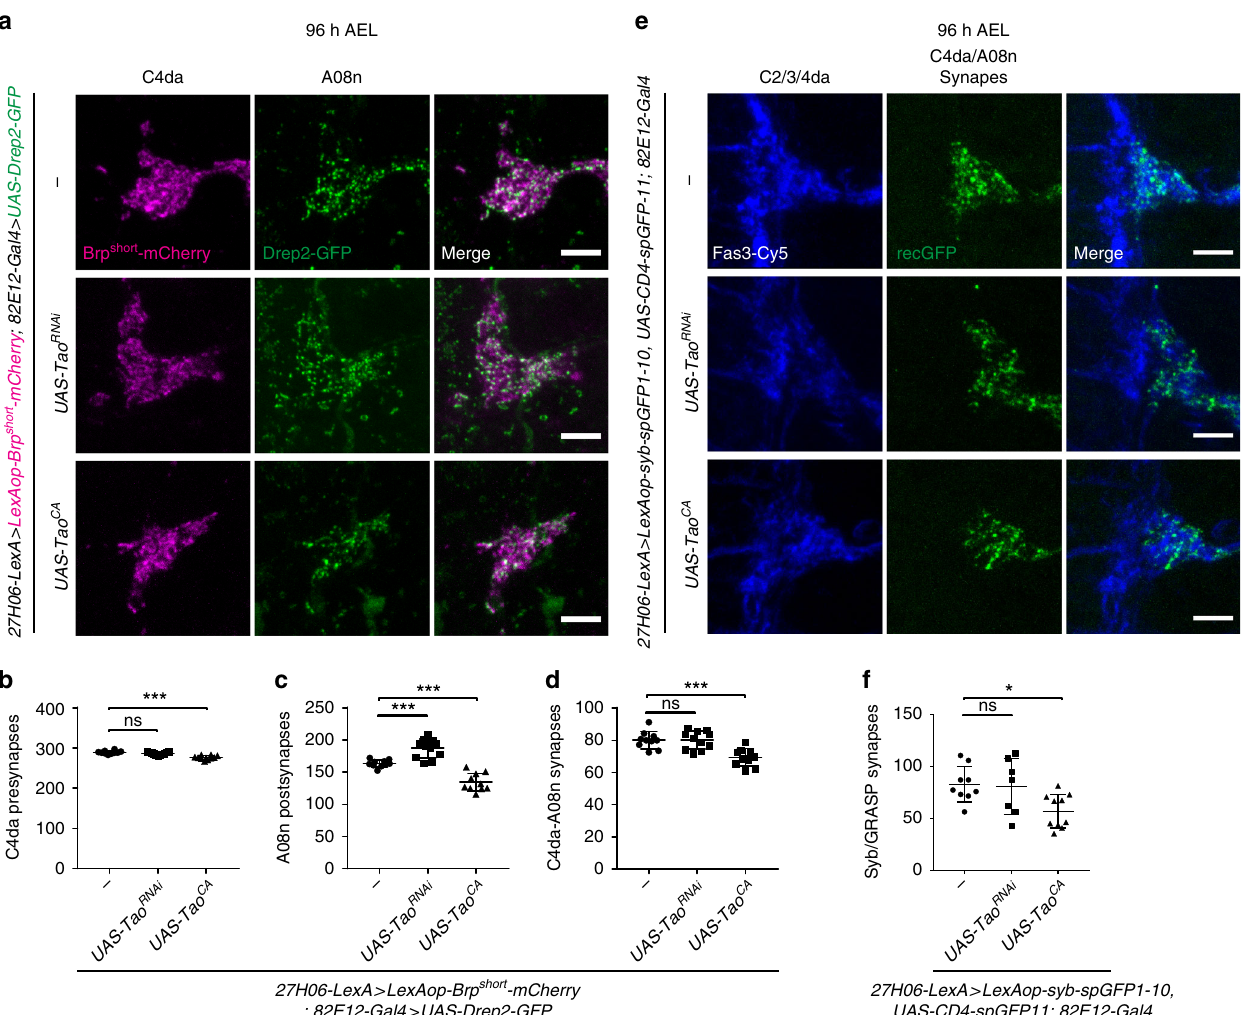
Fig. 3 Tao kinase regulates postsynaptic growth of A08n neurons. a Confocal images of hemisegments in control or with Tao RNAi and Tao CA expression in A08n neurons using synaptic markers labeling of C4da presynapses (magenta) and A08n postsynapses (green). Scale bar = 5 µ m. b Quanti fi cation of C4da presynaptic, c A08n postsynaptic, and d colocalized C4da – A08n synaptic markers in control or with Tao RNAi and Tao CA expression in A08n neurons. *** P < 0.001, **** P < 0.0001± SD, ANOVA with multiple comparisons and Dunnett ’ s post-hoc test (for exact P- values and statistics see Supplementary Data 1). Control n = 10, UAS-Tao RNAi n = 11, UAS-Tao CA n = 10. e Confocal images of Syb-GRASP-labeled C4da – A08n synapses. Hemisegments of control animals or with Tao RNAi and Tao CA expression in A08n neurons together with anti-Fas3 staining are shown. Fas3 labels C2da, C3da, and C4da sensory axons (blue) overlapping with reconstituted GFP signal within the C4da neuron domain (green). Scale bar = 5 µ m. f Quanti fi cation of C4da – A08n neuron synapses using Syb-GRASP under control conditions or with Tao RNAi and Tao CA expression in A08n neurons. Control n = 9, UAS-Tao RNAi n = 7, UAS-Tao CA n = 10. * P < 0.05 ± SD, ANOVA with multiple comparisons and Dunnett ’ s post-hoc test (for exact P- values and statistics see Supplementary Data